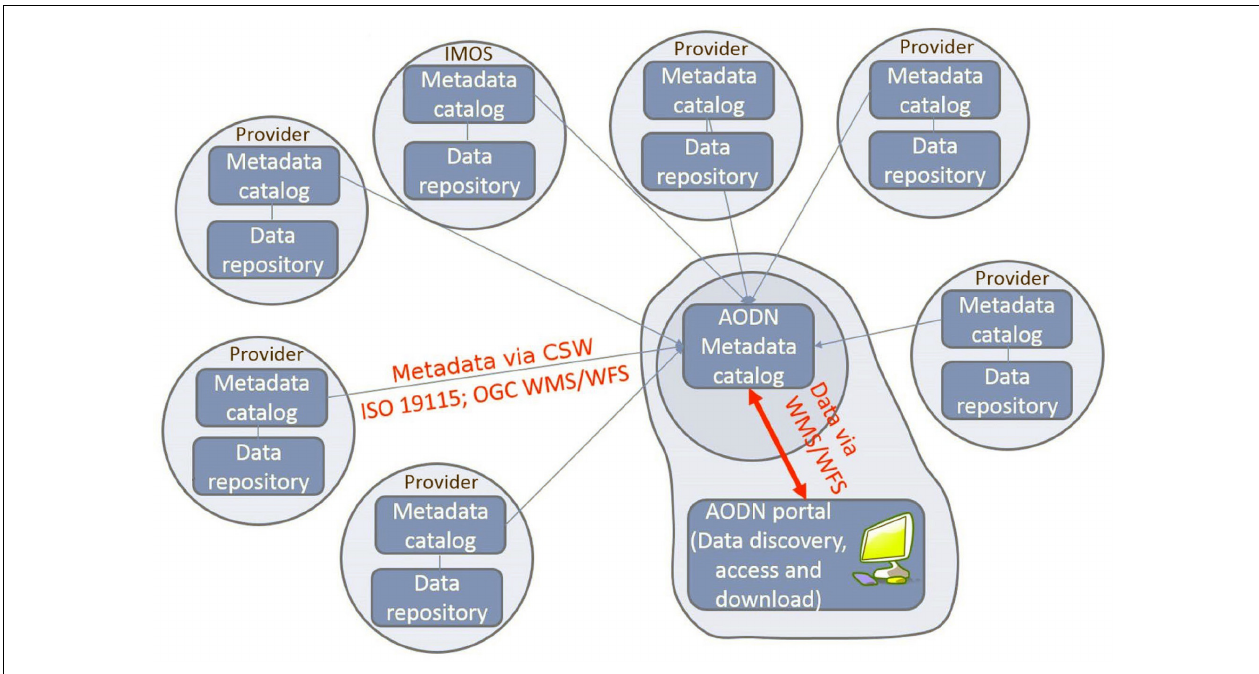
FIGURE 8 | The AODN portal as an example of a network of interoperable data services. Source: Hidas et al. (2016). Used under CC BY (http://creativecommons.org/licenses/by/4.0)/updated to remove the IMOS portal, which no longer